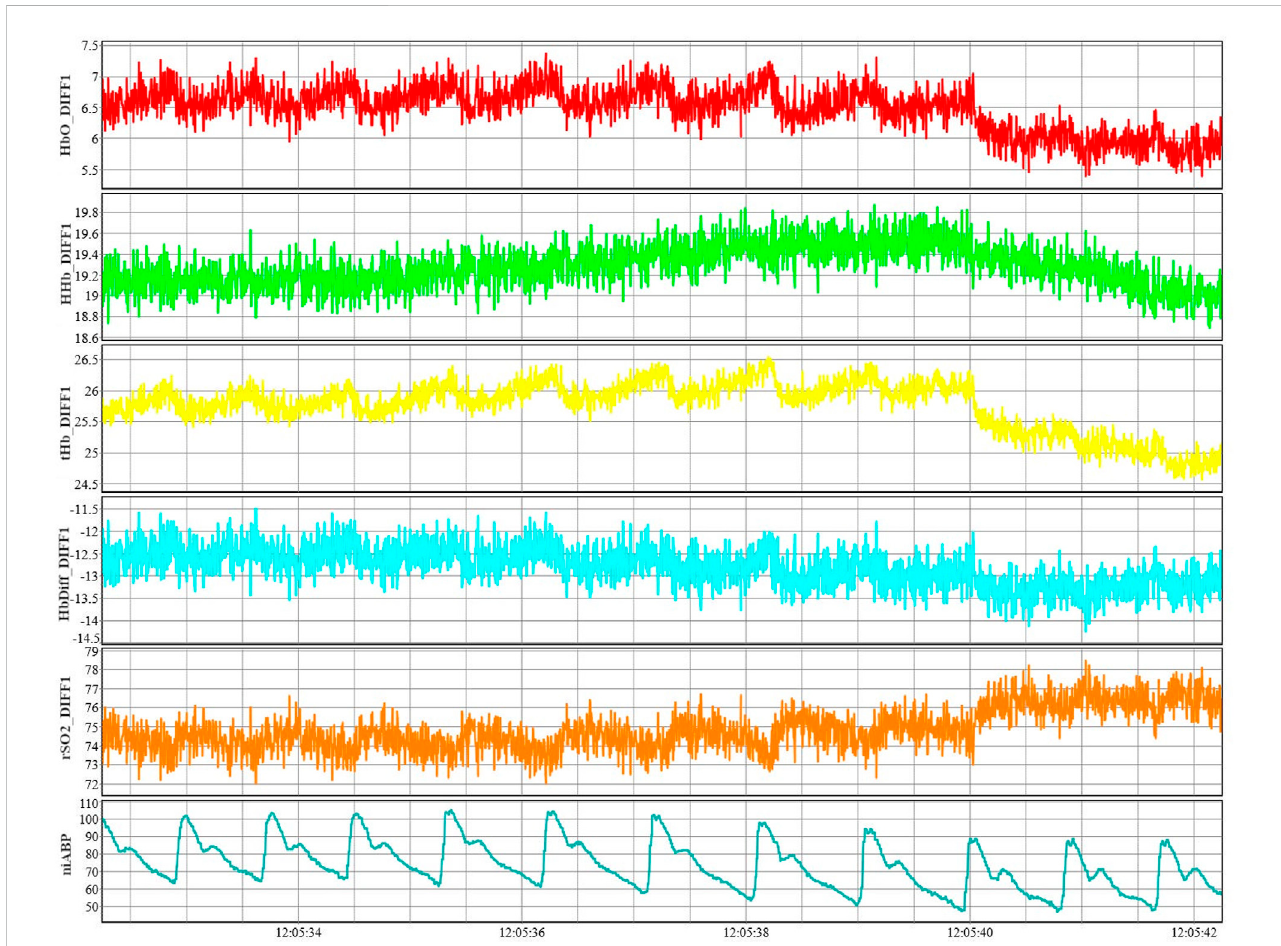
FIGURE 3 Example of NIRS signals from a single channel along with niABP signal. An example of NIRS signals of HbO, HHb, tHb, HbDiff, and rSO 2 shown from channel 1 along with an example of niABP signal.NiABP, non-invasive continuous arterial blood pressure; HbO, oxyhemoglobin; HHb, deoxyhemoglobin, NIRS, near-infrared spectroscopy; tHb, total hemoglobin; HbDiff, difference between HbO and HHb; rSO 2 , regional cerebral oxygen